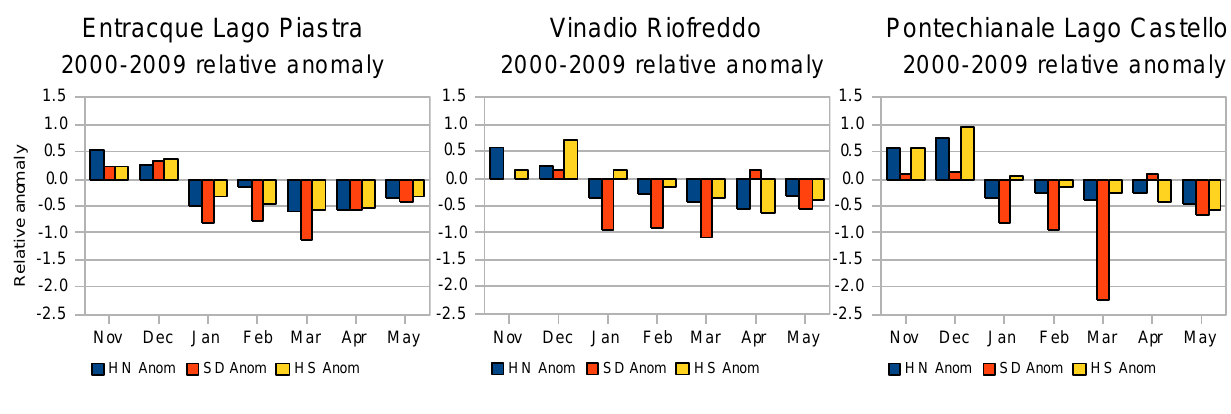
Figure 2 . The relative anomaly [adimensional] of average monthly cumulated snowfall (HN), snowy days (SD), and snow depth (HS), for the 2000–2009 decade with respect to the 1971–2000 reference period in the three stations considered in this